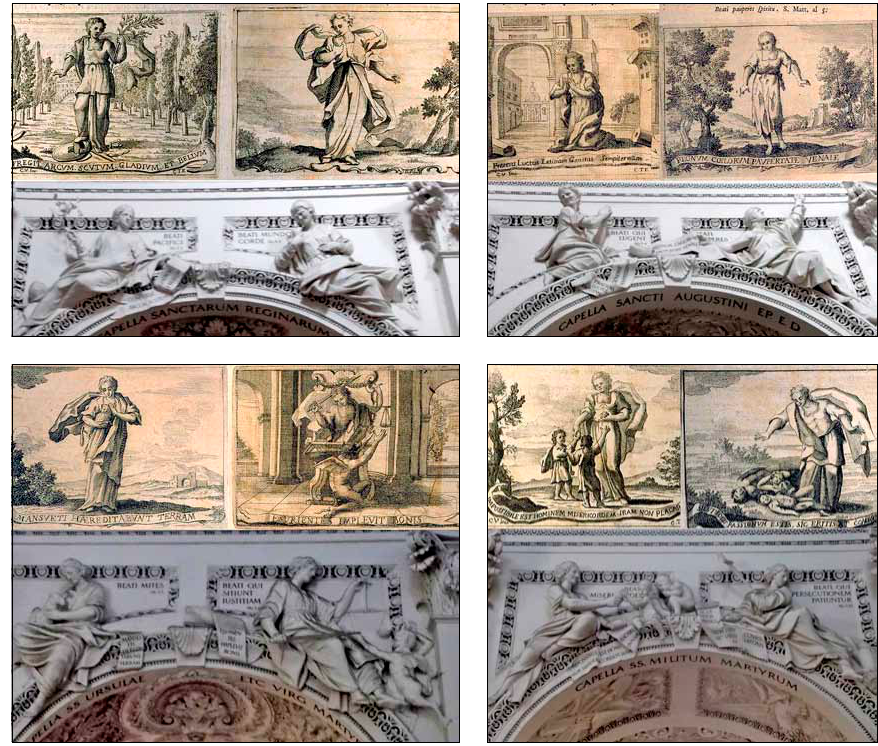
fig. 7. Illustrations of eight beatitudes from “Iconologia” book by C. ripa (first published in 1610–1611, Padua) served as the source of inspiration for figures of beatitudes in St. Peter and St. Paul’s Church in Vilnius. Source :